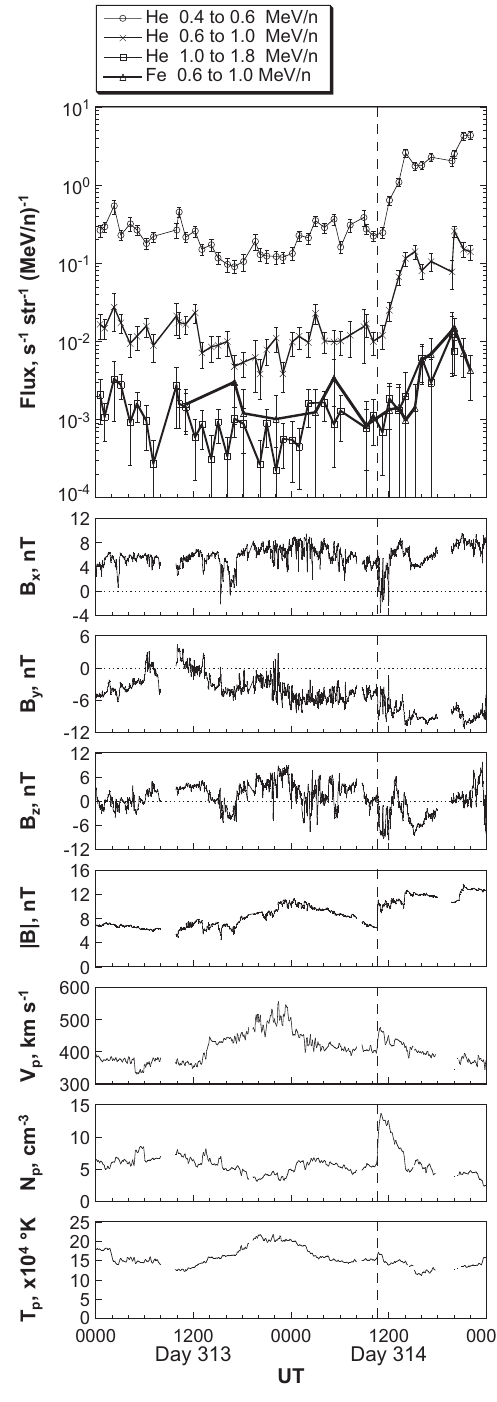
Fig. 5. He ( 3 He+ 4 He) flux, plasma and magnetic field data for the 9 November 1980 event.